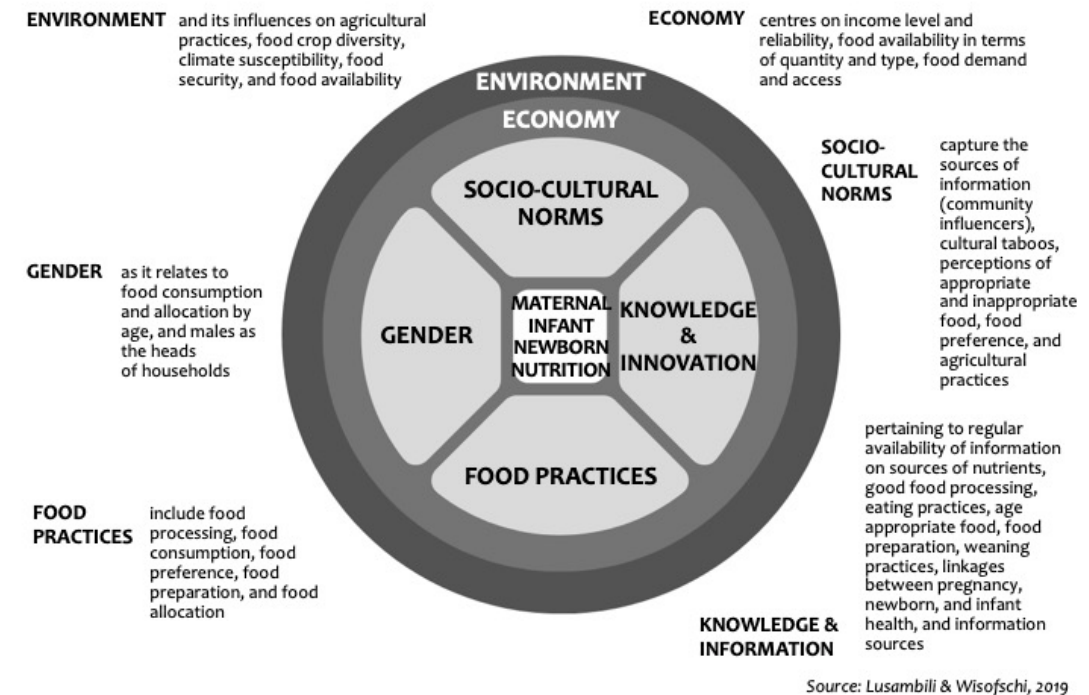
Figure 1. Conceptual Framework.